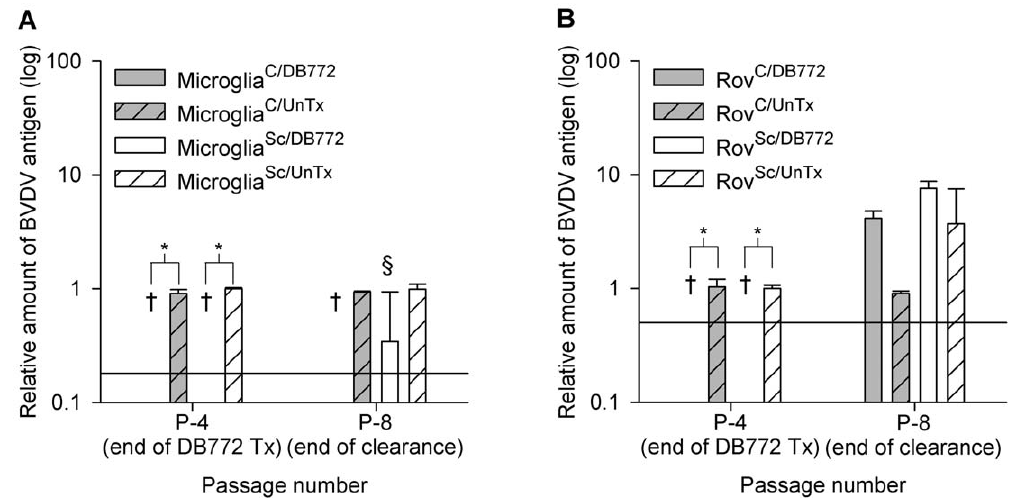
Figure 2. DB772 inhibits BVDV in primary sheep microglia (A) and Rov9 cells (B). Cells were inoculated with BVDV-containing PrP Sc inoculum [55]. Following establishment of PrP Sc accumulation, treatment groups were maintained in culture with 4 m M of DB772 for four passages. At the fourth passage (P-4, end of DB772 Tx), an aliquot of cells was lysed for BVDV antigen ELISA. All cultures were then continued for another four passages without DB772. Cells were collected for BVDV antigen ELISA at the end of those four clearance passages (P-8, end of clearance). A standard curve was used to transform the corrected optical densities into relative concentration of BVDV antigen. Data columns represent the means 6 one standard deviation. Results at each passage were statistically compared between DB772-treated and untreated groups. The y-axis reference line indicates the minimum detection limit of the ELISA. *, P , 0.001. { , below assay detection limit. 1 , one positive sample.